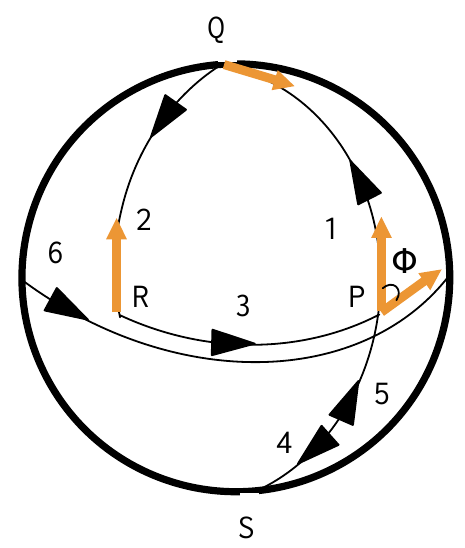
FIG. 2. (Color) The geodesic curve G described by ˆ e z on the unit-radius sphere S 2 corresponding to Fig. 1. The unit vector ˆ e x is displayed at each point on G . At s (cid:1) 0 1 , ˆ e z is at P in the figure, and ˆ e x (the dotted arrow) lies along the equator. Entering magnet #1, ˆ e z moves to Q, and ˆ e x is parallel transported. The same happens moving through magnets #2 and #3. Then ˆ e z comes back to P. In going through magnets #4 and #5 from P to S, ˆ e z makes a round-trip (null contribution to F ). The same happens going through magnet #6, along the equator ( 2 p contribution to F ). On returning to P, ˆ e x is tilted by F (cid:1) p (cid:3) 2 . The solid angle is p (cid:3) 2 1 2 p [ (cid:8) F , mod (cid:1) 2 p (cid:2)